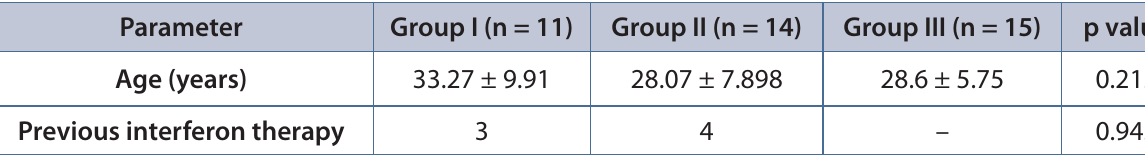
Table 1. Clinical data of thrombocytopenic patients